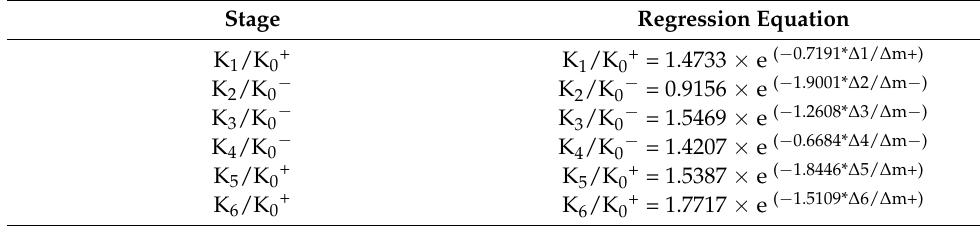
( c ) Figure 16. Comparison of hysteresis curves obtained by the restoring-force model and experiment: ( a ) Specimen UX-1; ( b ) Specimen UX-2; ( c ) Specimen UX-3. 5. Conclusions This paper reviewed the development of the ring-lapped splice beam-column con- nection to improve the connection quality of precast reinforced concrete components and their cyclic performance with different lap lengths. On this basis, a restoring-force model was established based on measured load-displacement curves considering the softening or stiffness degradation. The main conclusions are as follows: